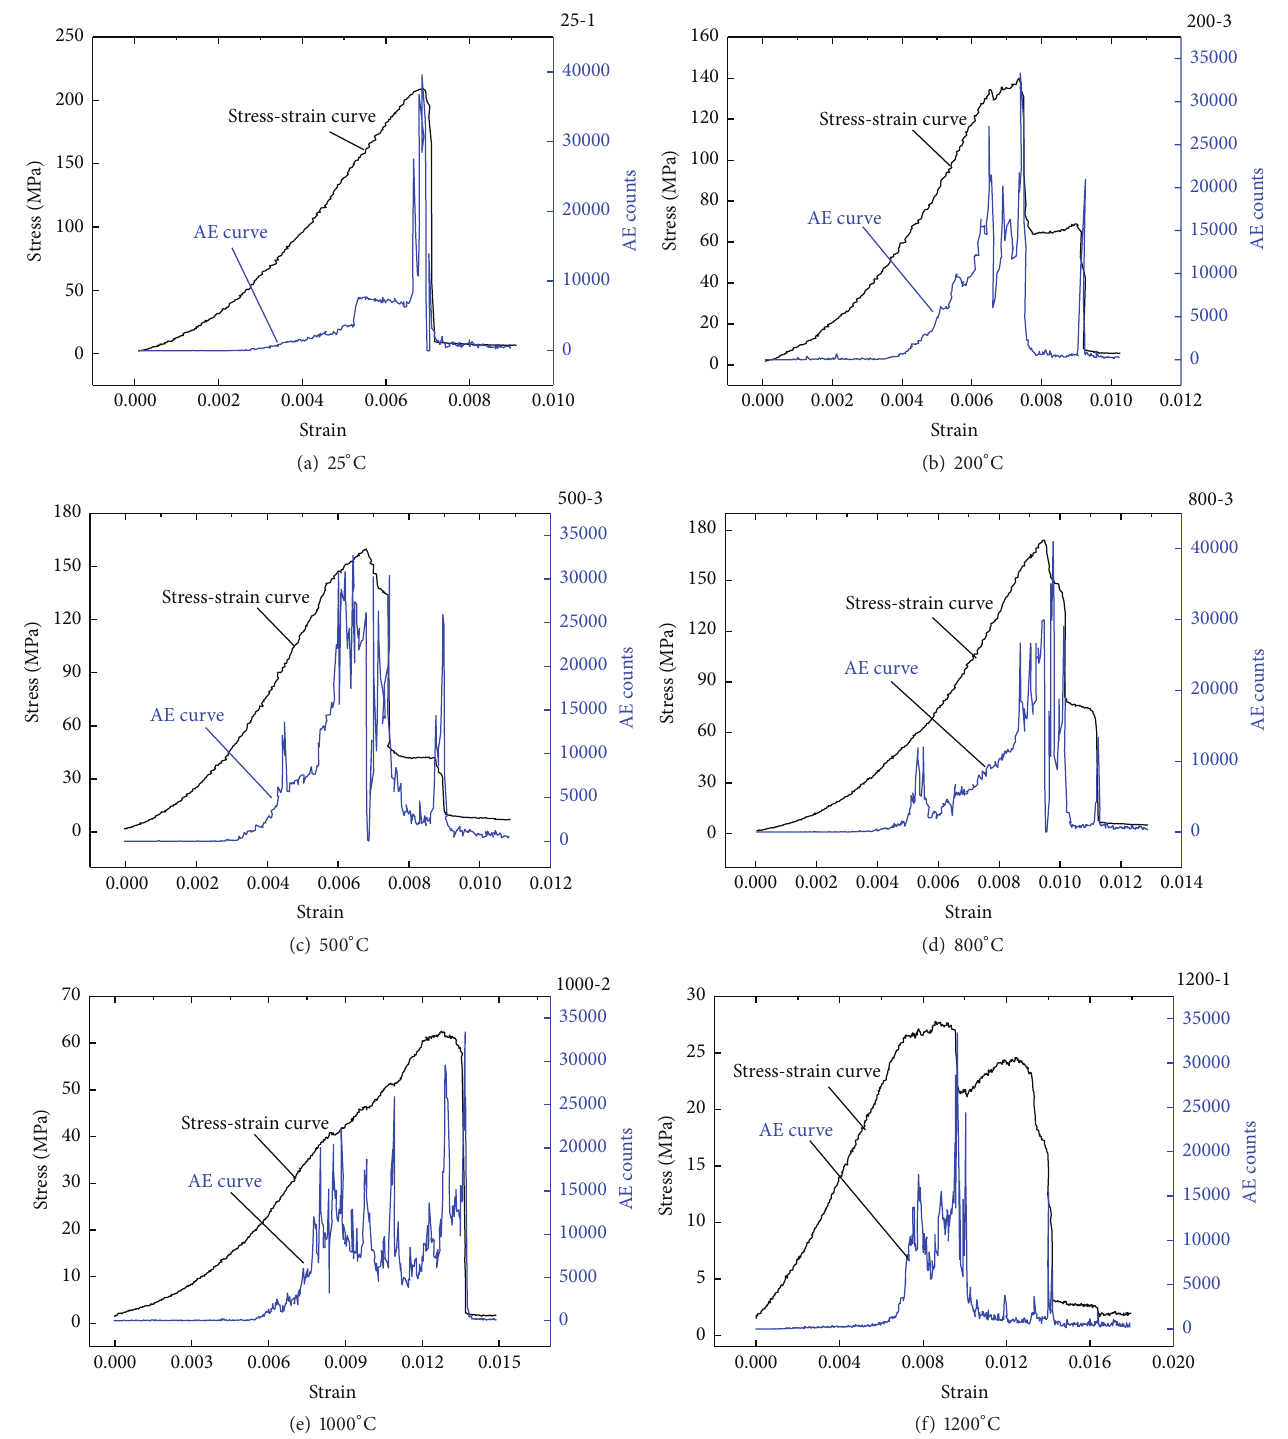
Figure 6: Relationship between stress-strain curve and AE counts after different